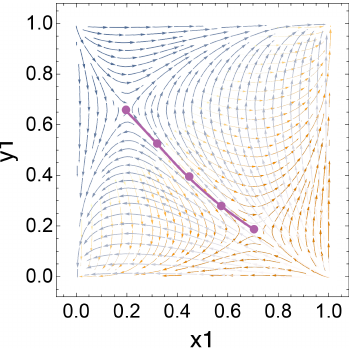
Figure 3. 2D attractor arc mapping on superimposed theoretical GameState payoff when n = 0 and n = 1, see Figure 1. The attractor arc represents the entirety of possible attractor positions given [ 0,1 ] . Reference points on the attractor arc demonstrate attractor positions when n = 0, n = 0.25, n ∈ n = 0.5, n = 0.75 and n = 1.